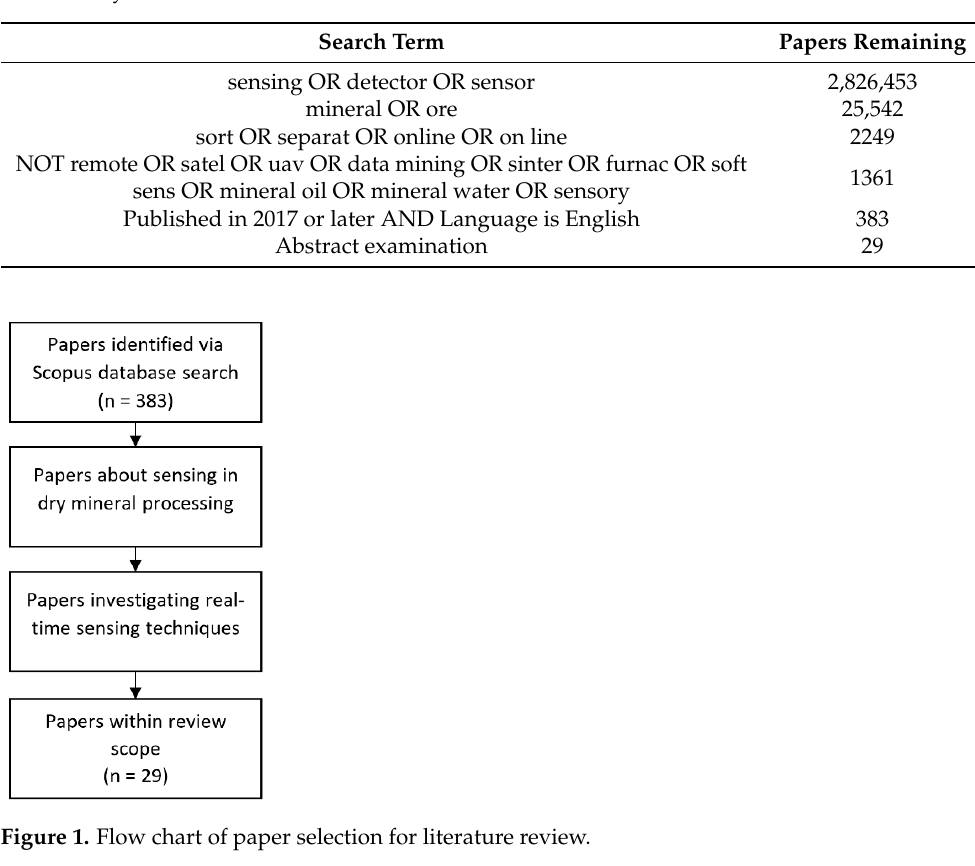
Table 1. Keywords for the literature search.